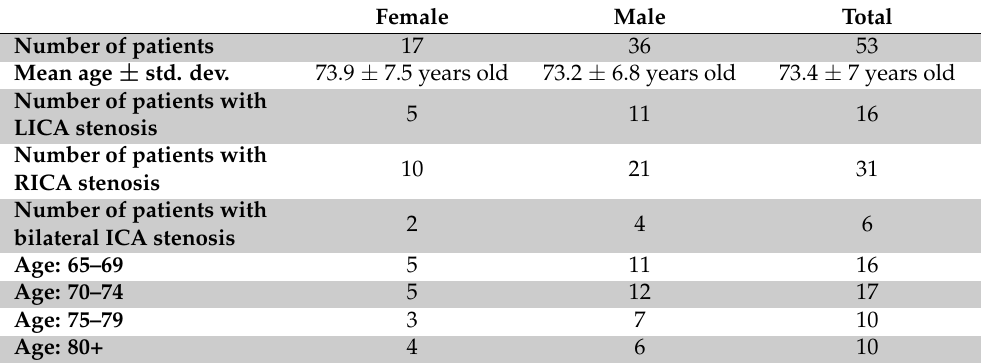
Table 1. Study group